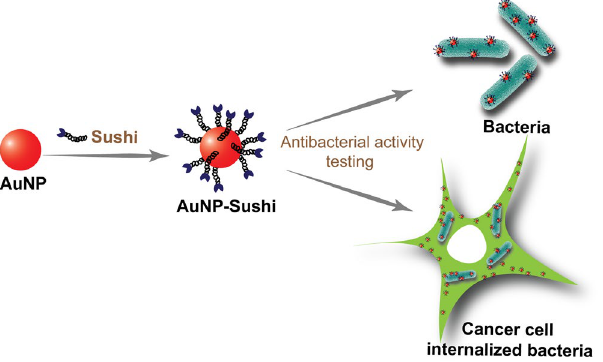
Figure 1. Schematic of approach: Sushi peptide molecules in the free and NP-conjugated forms tested for their antimicrobial activity on extracellular and HeLa-internalized bacterial